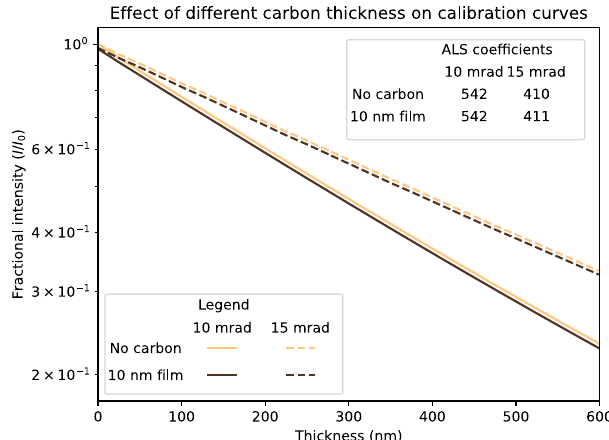
Fig. 4 MeasureIce generated calibration curves with and without a 10 nm amorphous carbon cryo-EM grid backing. The curves are linear if fractional intensity is plotted with a log scale and the effect of the carbon backing is to shift the origin of the line but not its slope (the ALS coef fi cient) so only the reference intensity ( I 0 ) need be set to that measured for just a carbon fi lm for ice thickness measurement with carbon backed